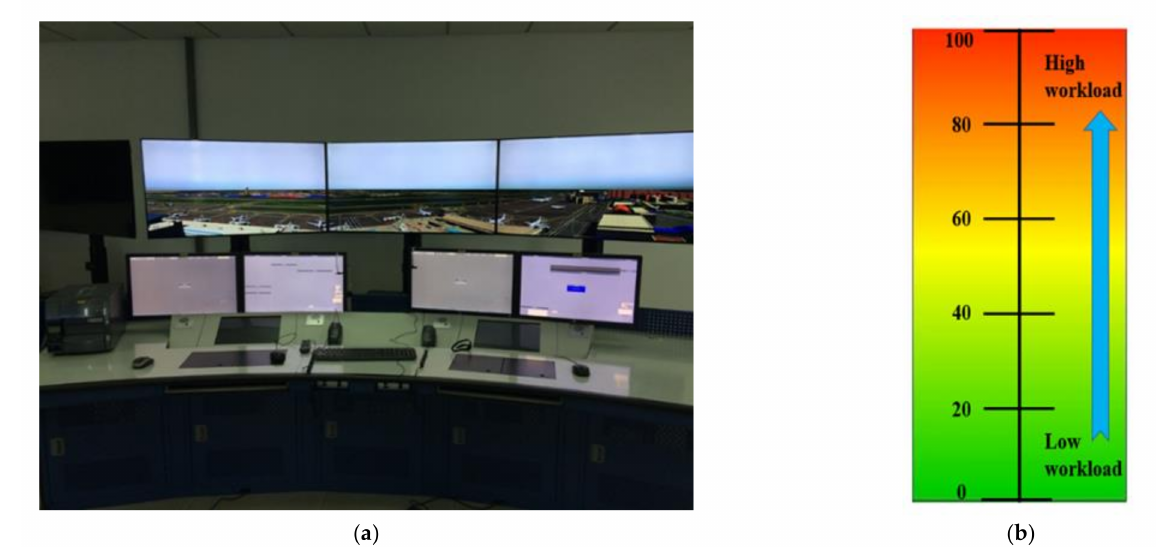
Figure 12. The tower simulation experiment. ( a ) The tower simulator; ( b ) the RSME scale for subjective workload rating.